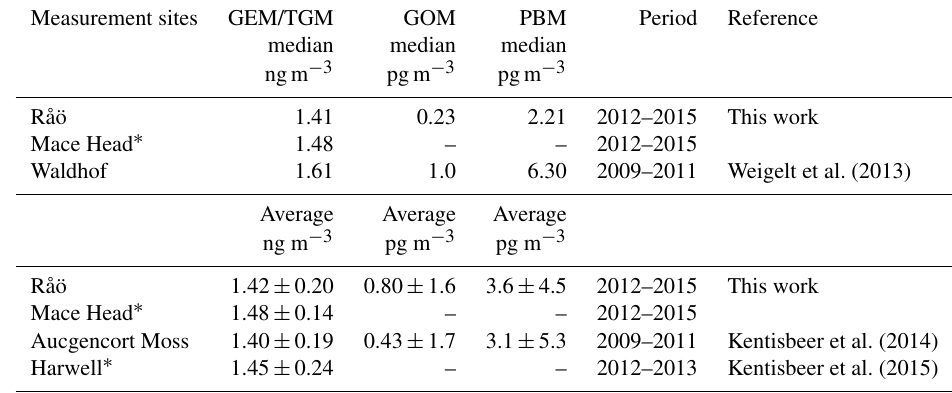
Table 1. Median and average mercury concentrations measured at some northern European sites. Measurement